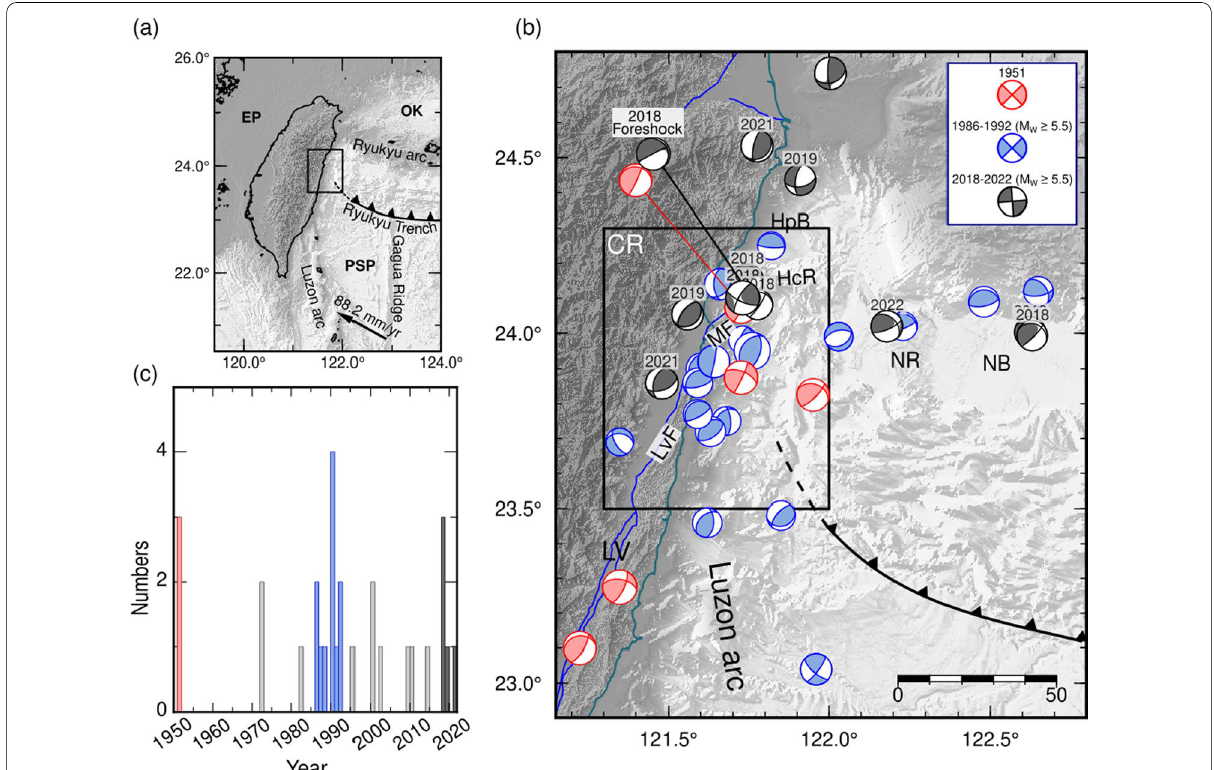
Fig. 1 Tectonic setting of northeastern Taiwan and focal mechanisms for three Hualien earthquake sequences: a map of tectonic conditions of collision between Luzon Arc and Eurasian Plate (EP) with oblique subduction of Philippine Sea Plate (PSP) beneath EP along Ryukyu Trench, where motion of PSP relative to the EP is indicated by black arrow; b focal mechanisms of three earthquake sequences for 1951 (Cheng 1997), 1986–1992 (Kao et al. 1998), and 2018–2022 (AutoBATS MT catalog; Jian et al., 2018a, b), where blue lines indicate active faults (Shyu et al., 2020) and dashed line indicates northwestward extension of Ryukyu Trench; c histogram of large earthquakes (M 5.5) between 1951 and 2021, where the beach ≥ balls in ( b ) and histograms are colored in accordance with earthquake sequences (note OK Okinawa Trough, CR Central Rage, LV Longitudinal Valley, MF Milun Fault, LvF Longitudinal Valley Fault, HcR Hsincheng Ridge, HpB Hoping Basin, NB Nanao Basin, NR Nanao